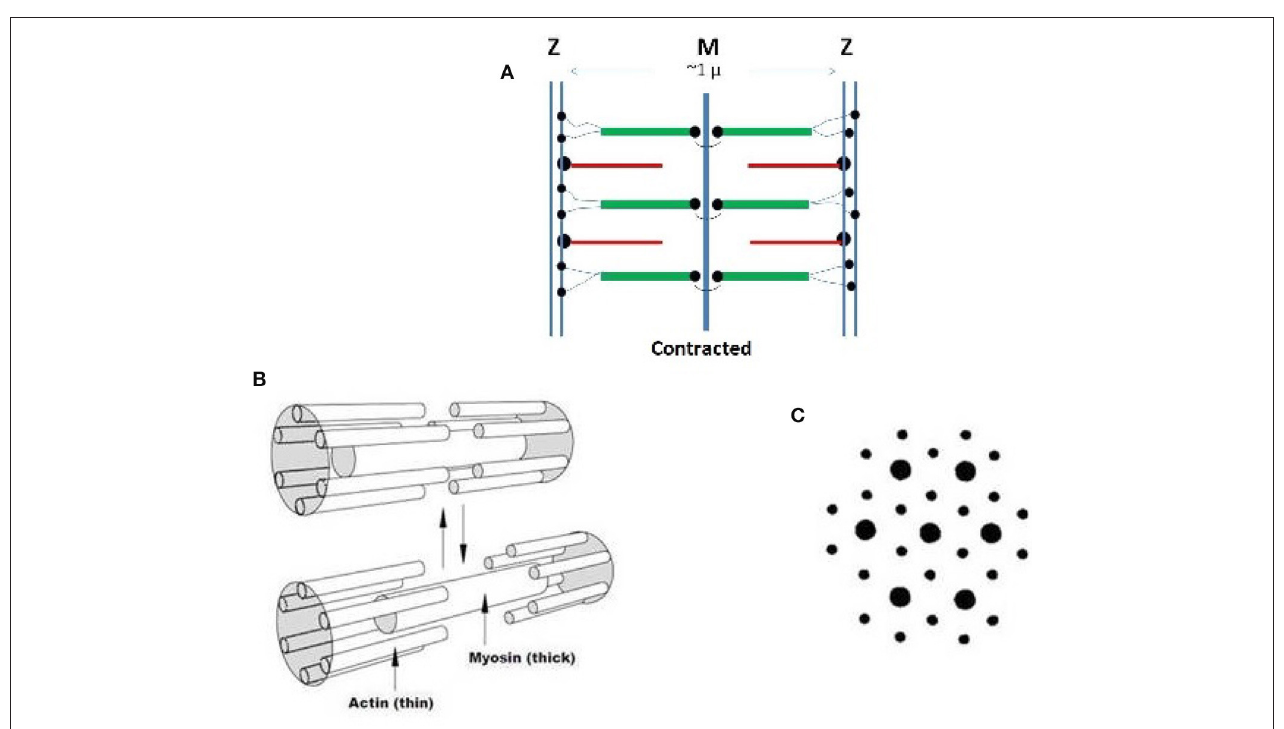
FIGURE 1 | (A) Schematization of the structure of a sarcomer in the contracted state based on high resolution optical microscopy. The Z lines limit the length of each repeating sarcomer along a myofibril. The thin filaments are based on rigid actin molecules with bound tropomyosin and troponin. Thin filaments are anchored to the Z region by the cross-linking protein alfa-actinin. The thick filaments) are firmly anchored to the central M zone and are based on rigid myosin bound to three to six tinin molecules. The N-terminals of flexible segments of titin connect each thick filament to the Z region, from which subsequent sarcomeric units depart. The terminal C-sections of titin stabilize opposite half-sarcomers overlaps in the central M zone. Note that thin filaments are polarized and myosin chains with opposite orientation must associate within the two half of a sarcomer. Dots indicate anchoring chemical bond. (B) Contraction-relaxation behavior of the smallest conceivable sarcometer that has six connected thin filaments around a thick one. The contracted state is favored by calcium ions released in the sarcometer. Reduction of ionic strength, favors a relaxation of the contraction. (C) Electron micrographs of a wider, contracted sarcometer reveal a hexagonal organization of the two types of filaments. Copyright 2014 Creative Common Attribution